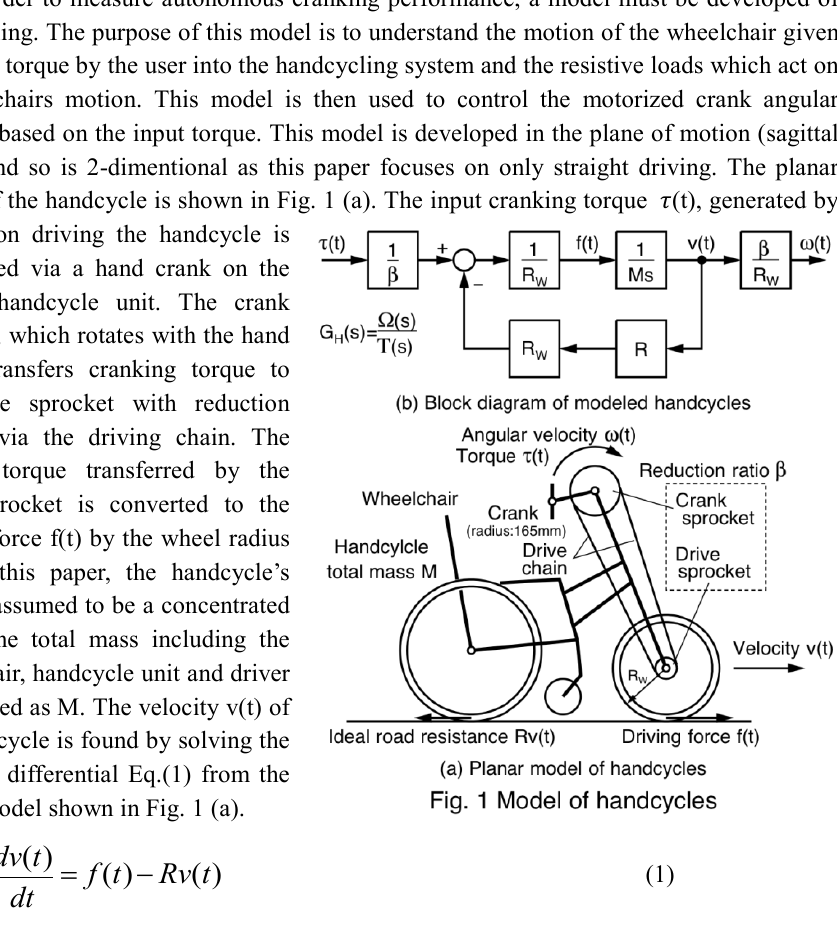
scribed at the summing point